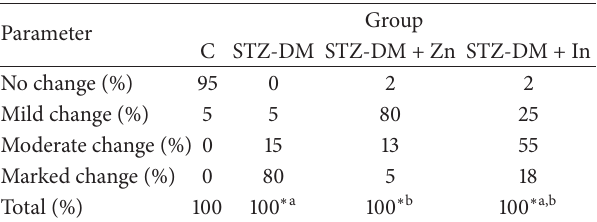
Table 4: Percentage of frequency distribution of vacuolar degener- ative changes in the different